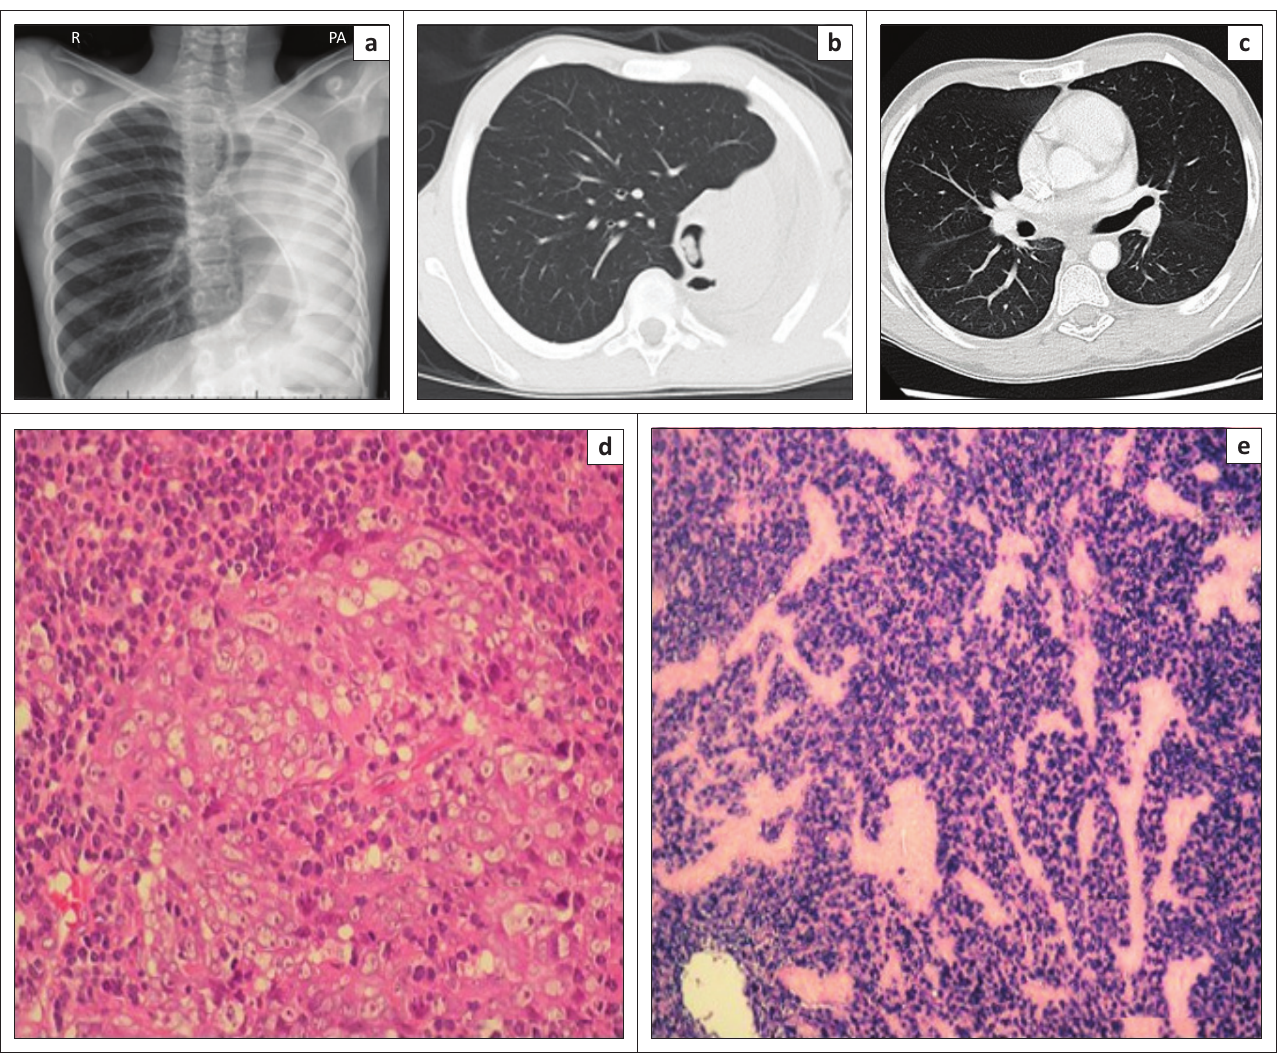
FIGURE 1: (a) Chest x-ray at presentation shows a collapsed left lung with mediastinal, tracheal and cardiac displacement, (b) CT scan at presentation demonstrates marked hyperinflation of the right lung with a collapsed left lung and a mass in the left main bronchus, (c) CT scan 6 months post-treatment completion shows normal lungs and no evidence of the bronchial mass, (d) Histological features of the tumour. Sheets of pleomorphic tumour cells with a syncytial arrangement infiltrated and surrounded by numerous lymphocytes, (e) EBER-ISH with strong